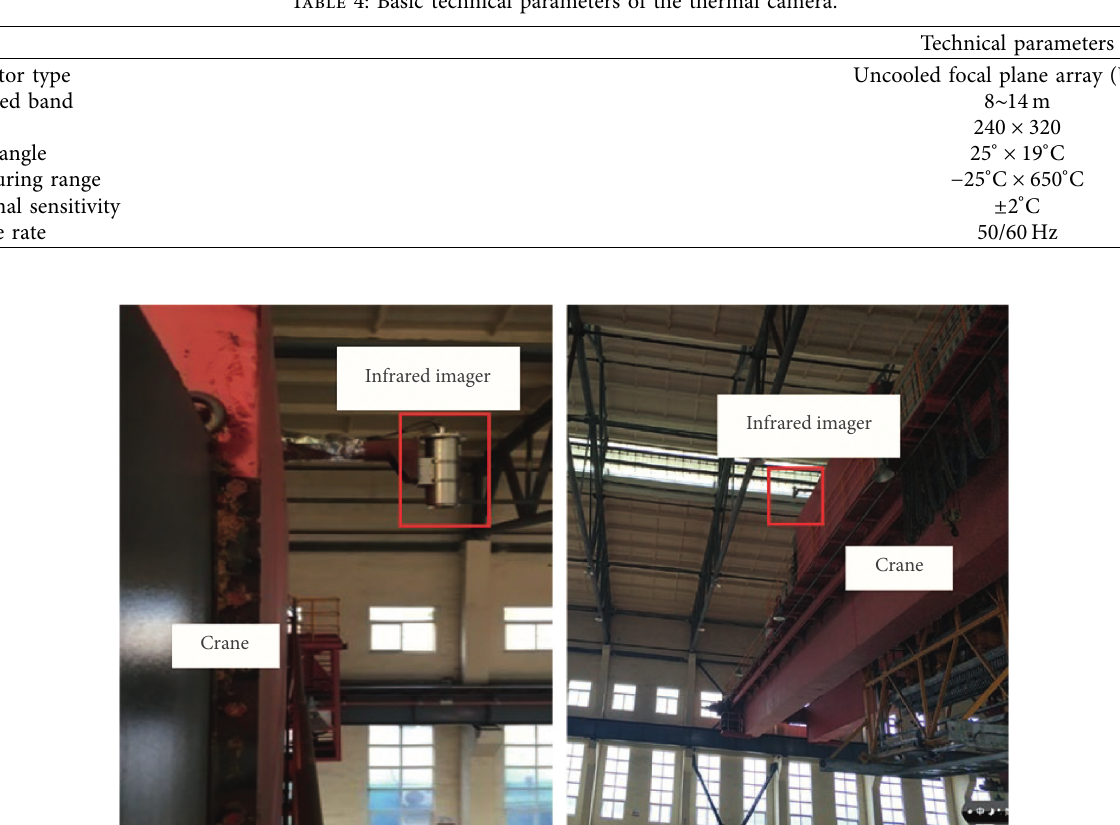
Table 4: Basic technical parameters of the thermal camera.